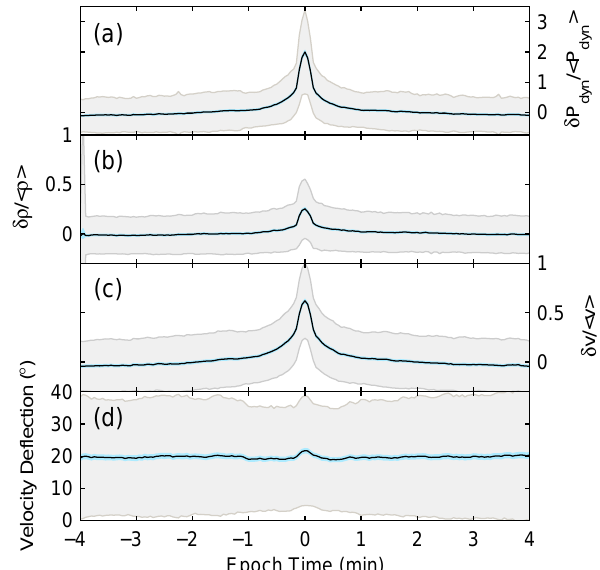
Fig. 5. Superposed epoch analysis of dynamic pressure enhance- ments. (a) Fractional change in dynamic pressure, (b) fractional change in density, (c) fractional change in flow speed, (d) angu- lar deflection of the velocity. Solid black lines represent the mean values, and corresponding standard deviations and 95% confidence intervals are shown in grey and blue,